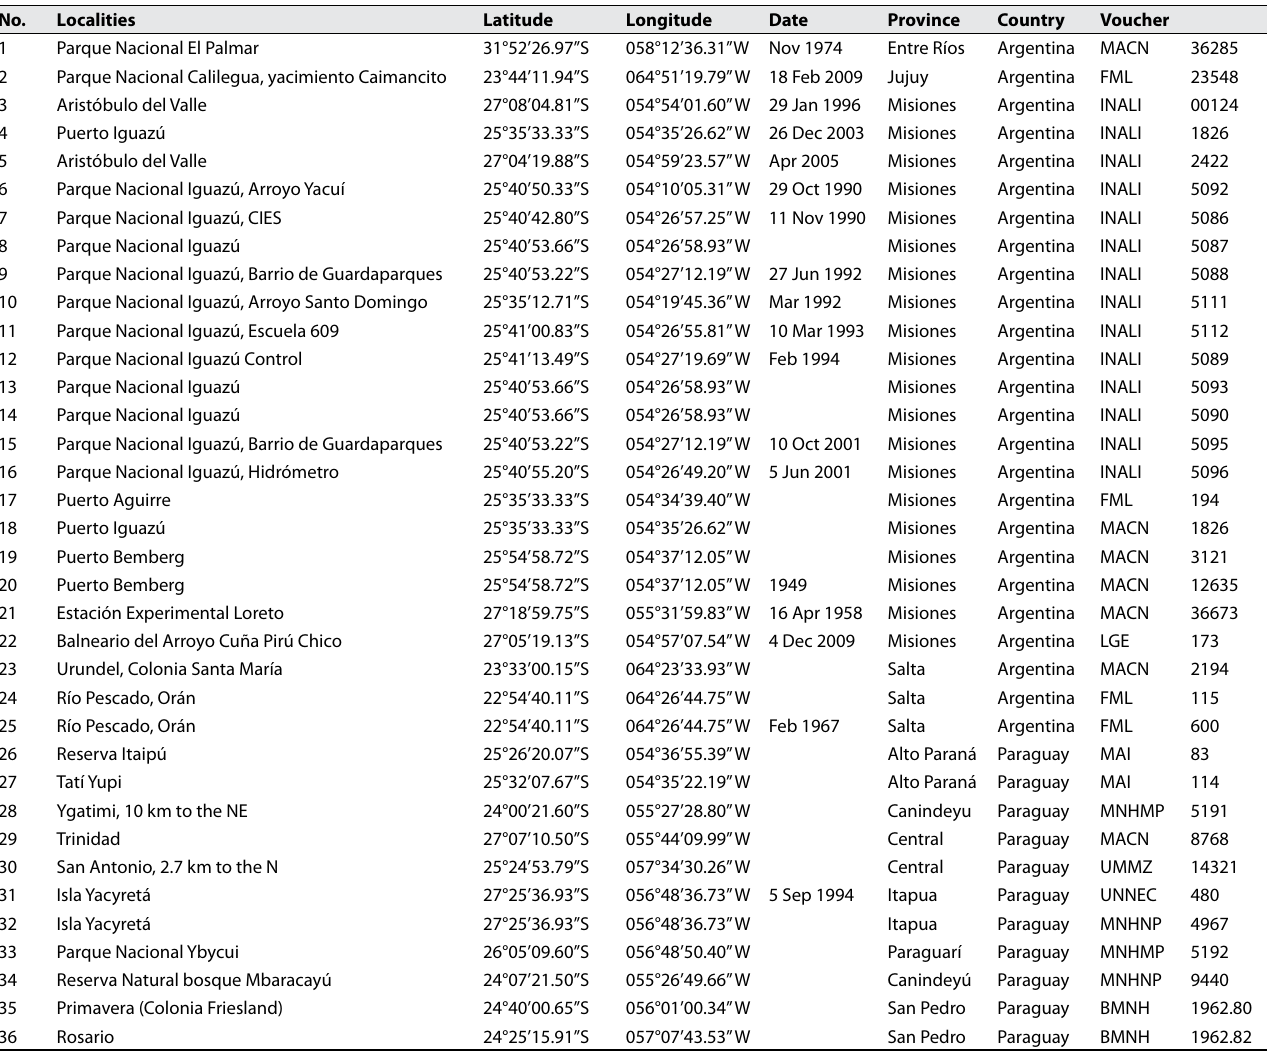
Table 1. Museum records of Erythrolamprus reginae with specific localities for Argentina and Paraguay.